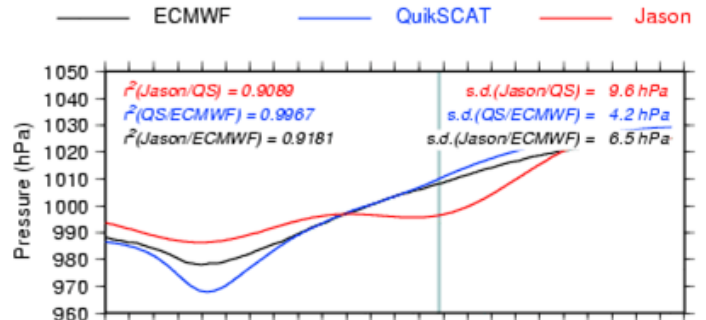
Figure 11. Comparison of the along-track SLP for the ETD of 11/01/2004 2:50 UTC QuikSCAT time. The abscissa shows the along-track distance in km (one stick every 100